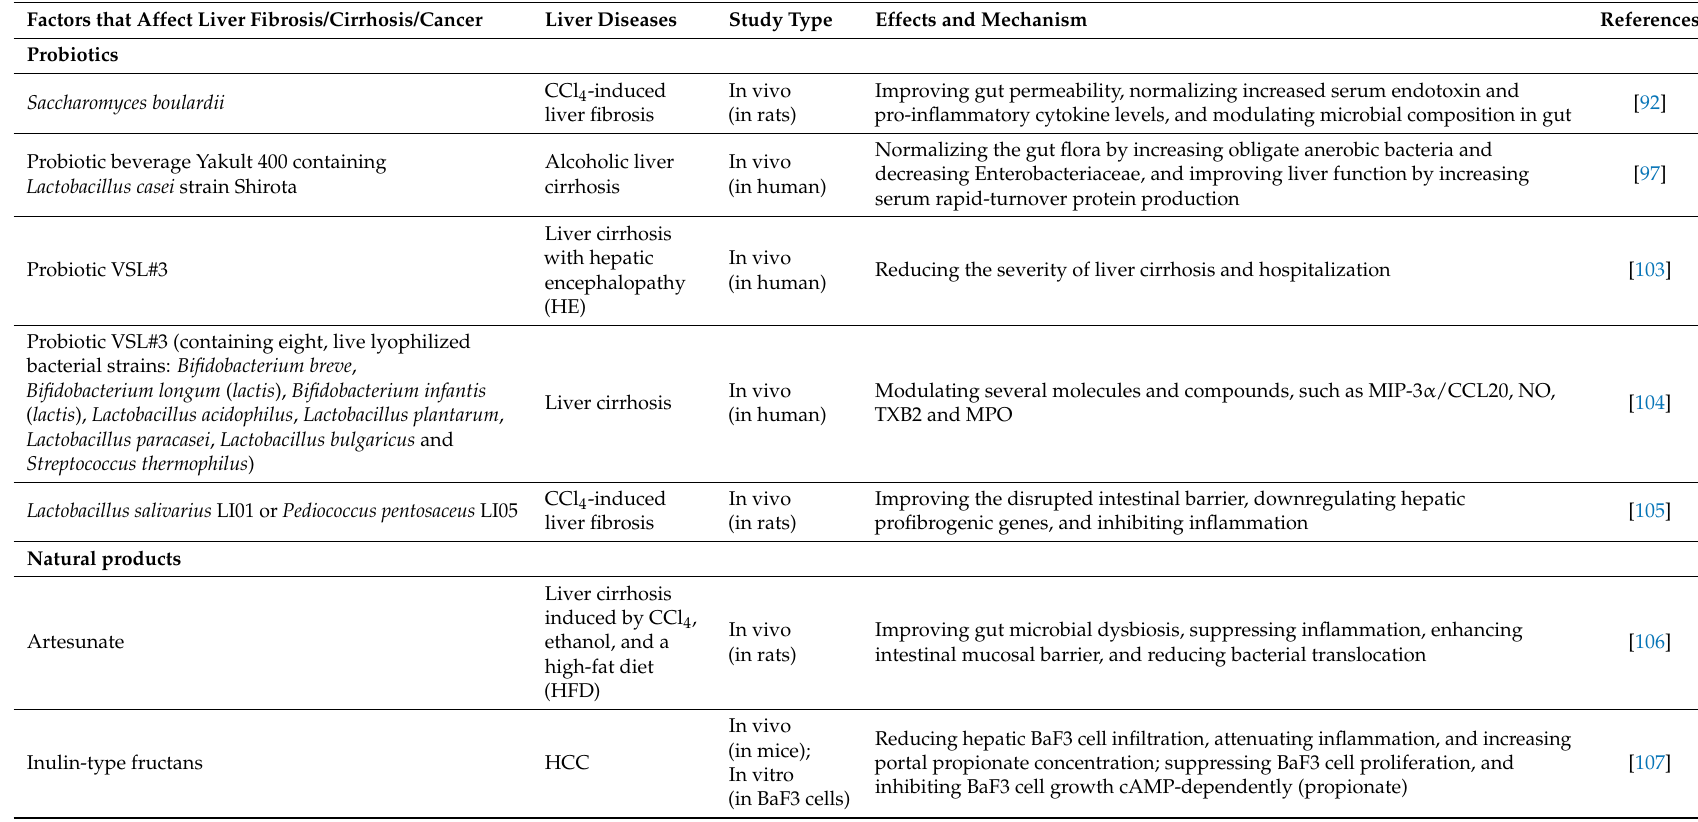
Table 3. Effects and mechanisms of natural products and probiotics on liver fibrosis, cirrhosis and cancer by modulating gut